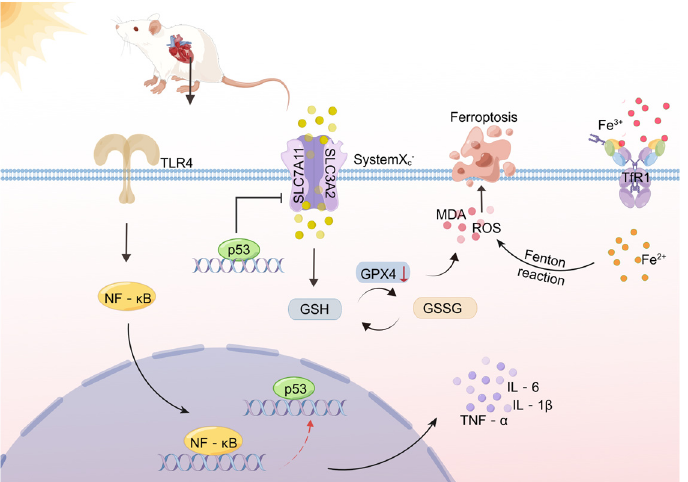
Figure 8. A schematic diagram of the research hypothesis concerning the inflammatory response and ferroptosis of cardiomyocytes caused by HS (by